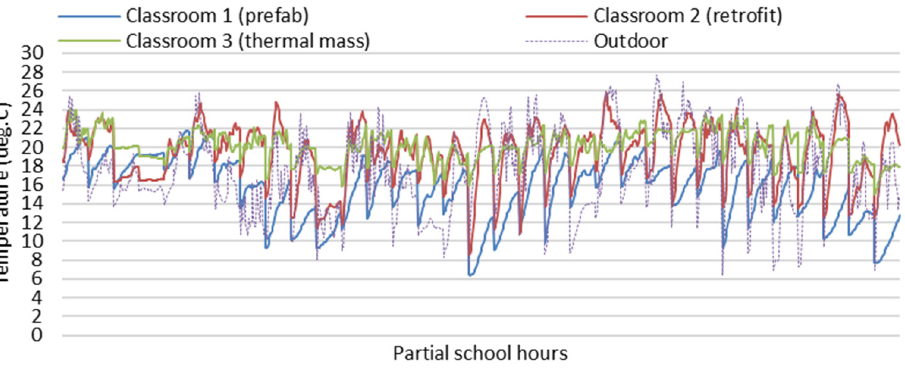
Figure 6. Field study data of indoor temperature of the three classrooms during school hours (8:30 a.m. to 3:30 p.m.).